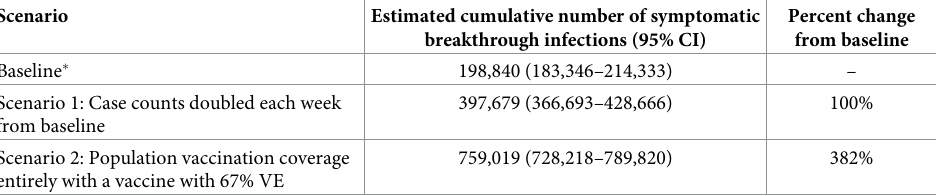
Table 2. Expected cumulative number of symptomatic COVID-19 vaccine breakthrough infections under differ- ing hypothetical scenarios of disease incidence, vaccination coverage, and vaccine efficacy—United States, Janu- ary–July